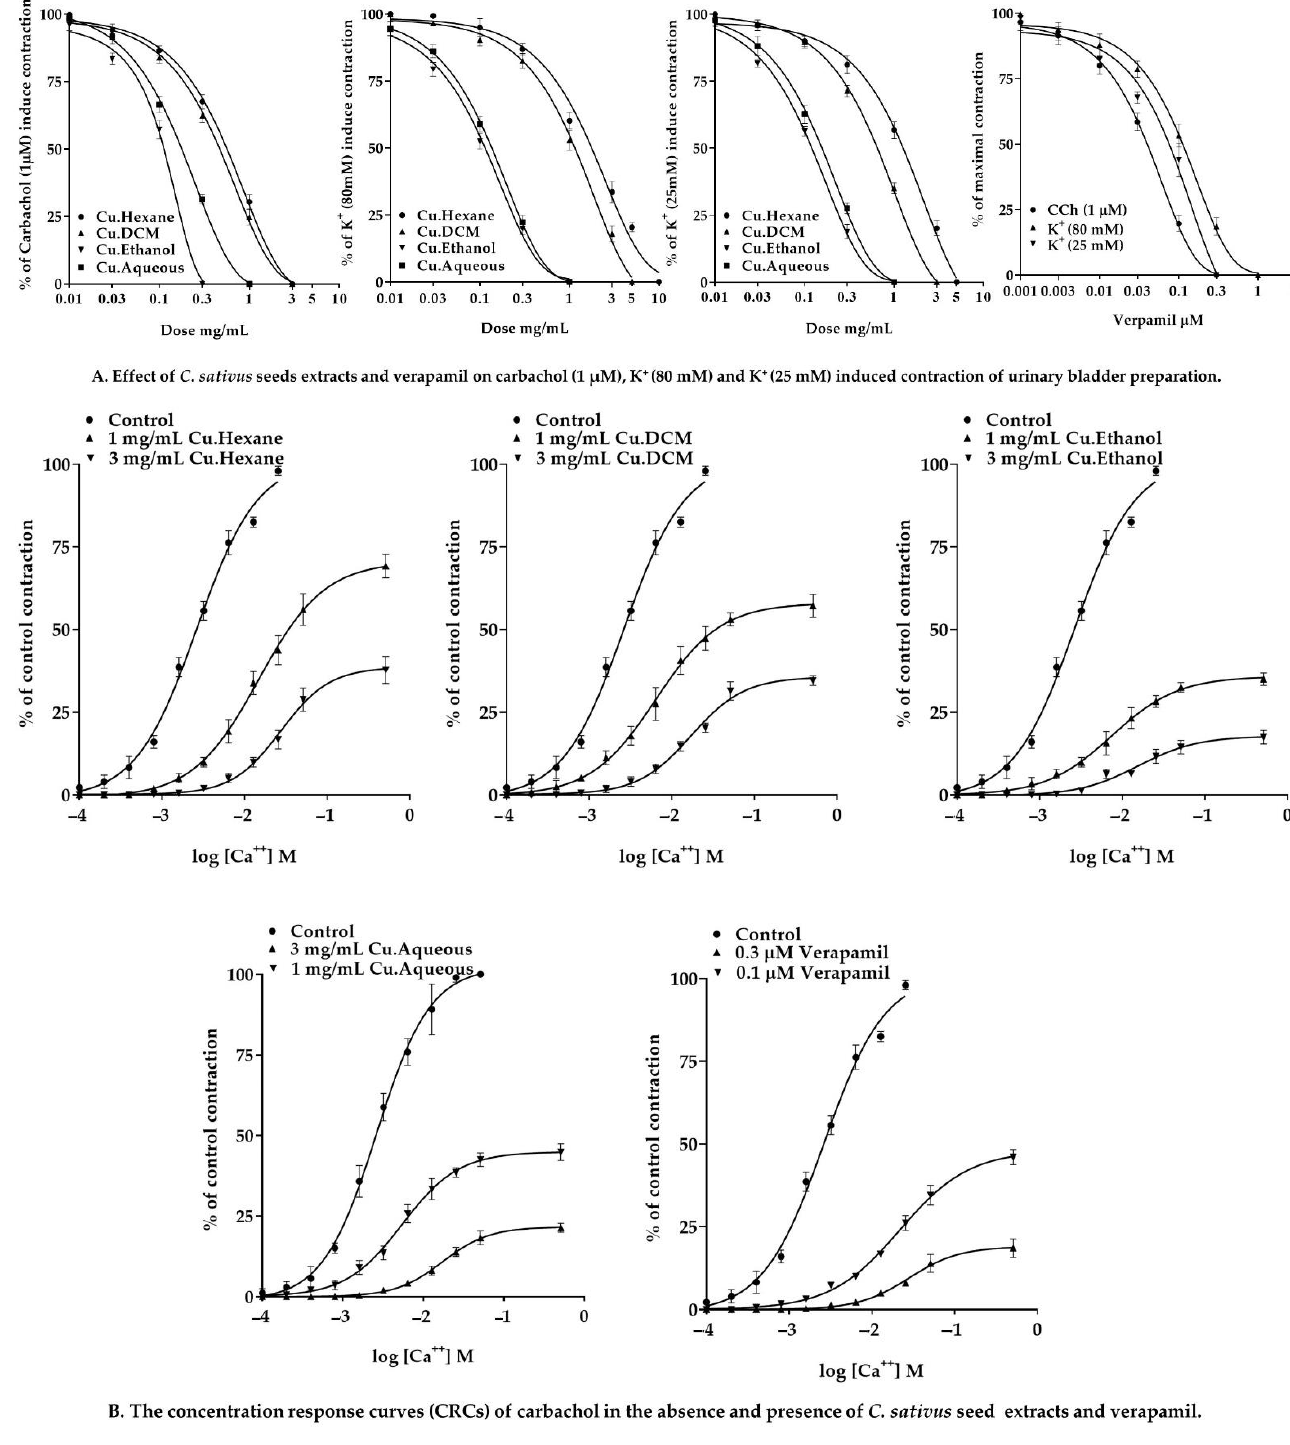
Figure 9. ( A ) Effect of C. sativus seed extracts and verapamil on spastic contractions of K + (80 mM), carbachol (1 µM), and K + (25 mM) on urinary bladder preparation; ( B ) Calcium concentration – response curves on urinary bladder preparation in the presence and absence of C. sativus seed extract and verapamil. Values are represented as the mean ± SD ( n = 5), and results were analyzed using a dose – response curve.